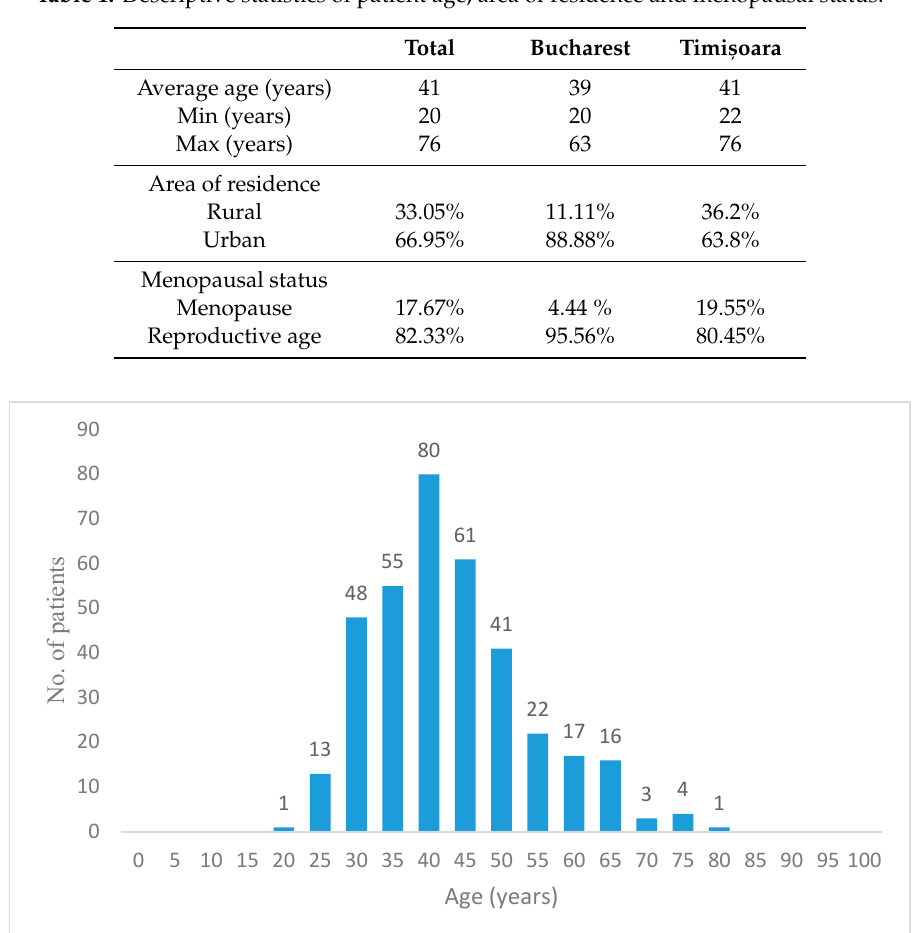
Figure 1. Patient distribution according to age groups.